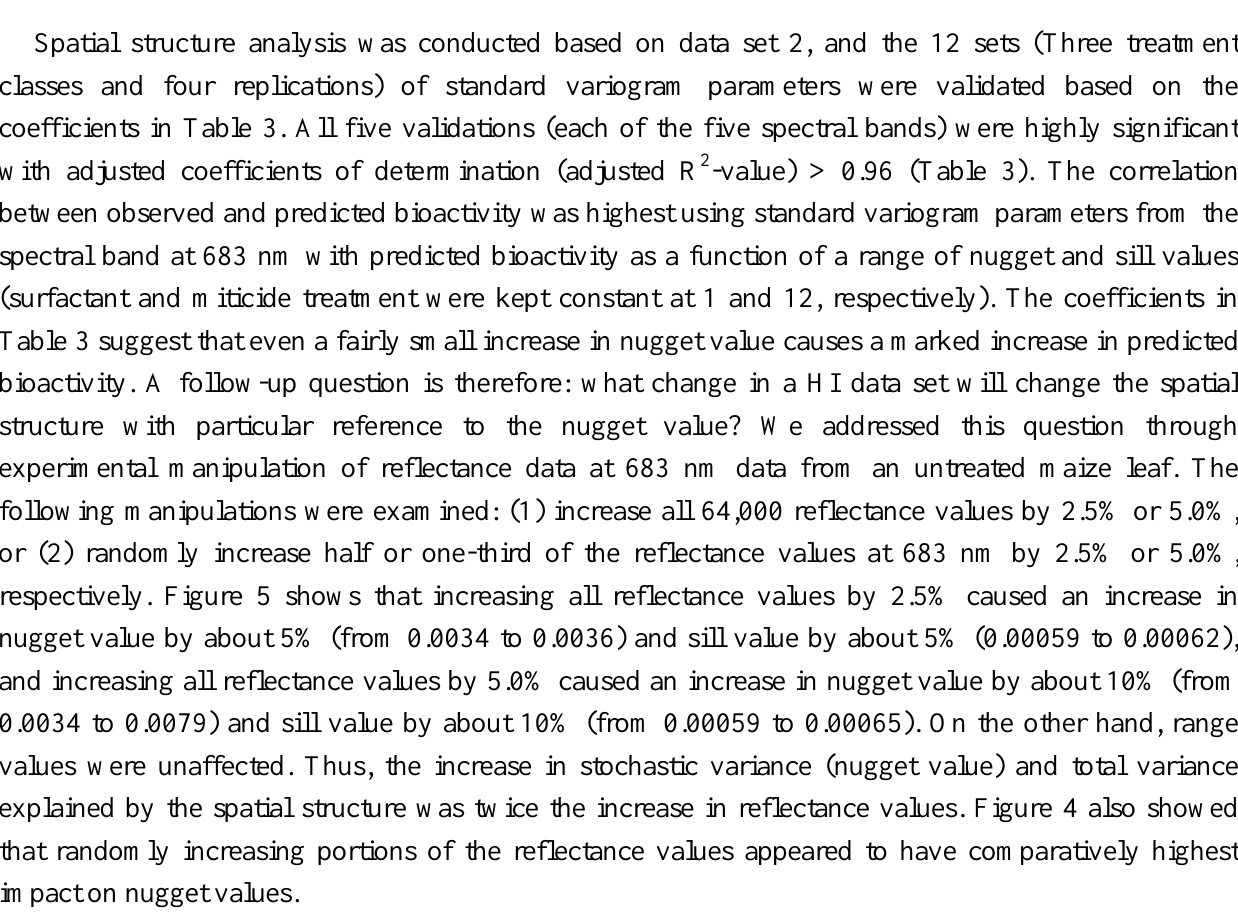
Figure 5. Variogram analysis of reflectance data from single spectral band (683 nm) of an untreated maize leaf were experimentally manipulated in four ways and compared with actual: multiplying all reflectance values with either 1.025 or 1.050 to simulate a 2.5% and 5.0% increase in all reflectance values or multiplying half the reflectance values (random selection) with 1.025 or one-third of the reflectance values (random selection) with